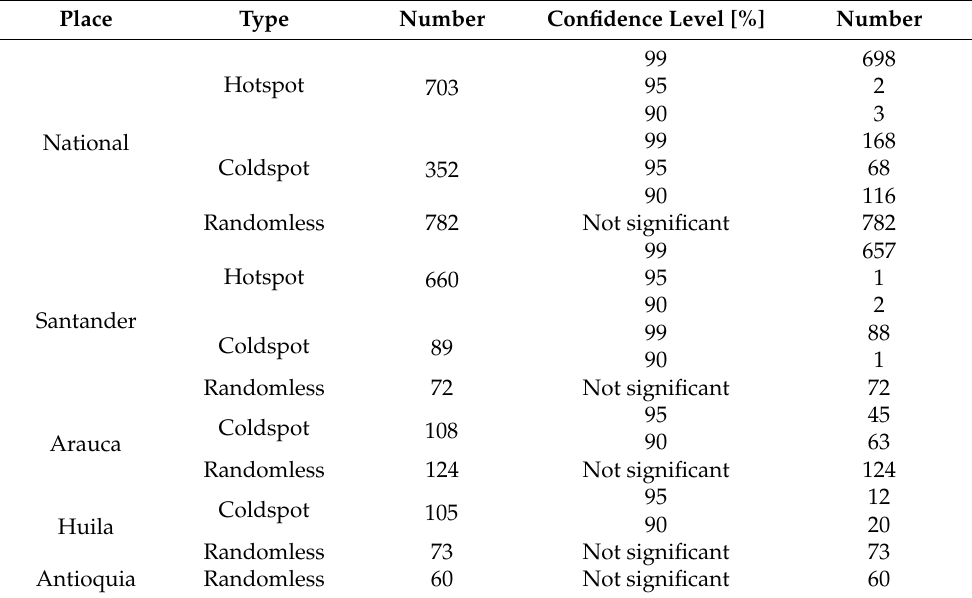
Table 3. Results of the hotspot and coldspot analysis both nationwide and in four main cacao- growing